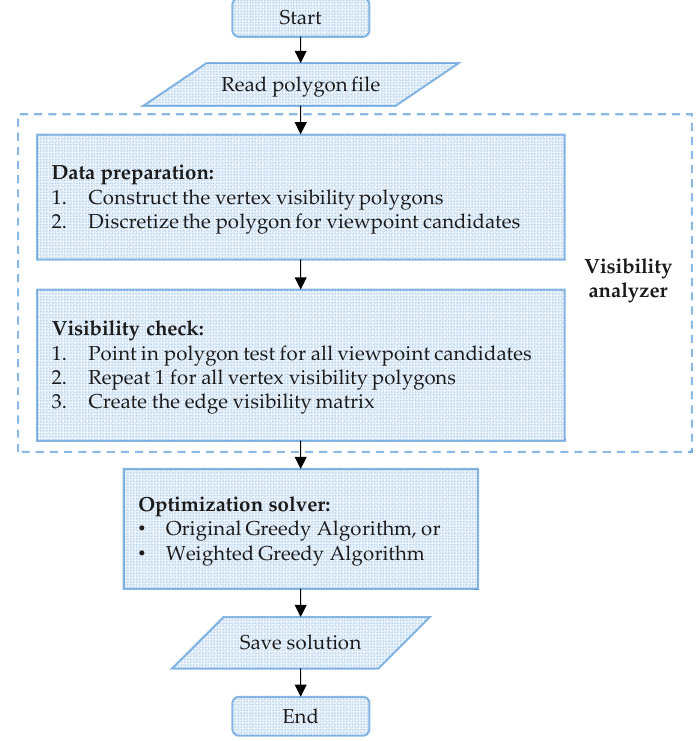
Figure 6. Flowchart of the proposed viewpoint planning method.